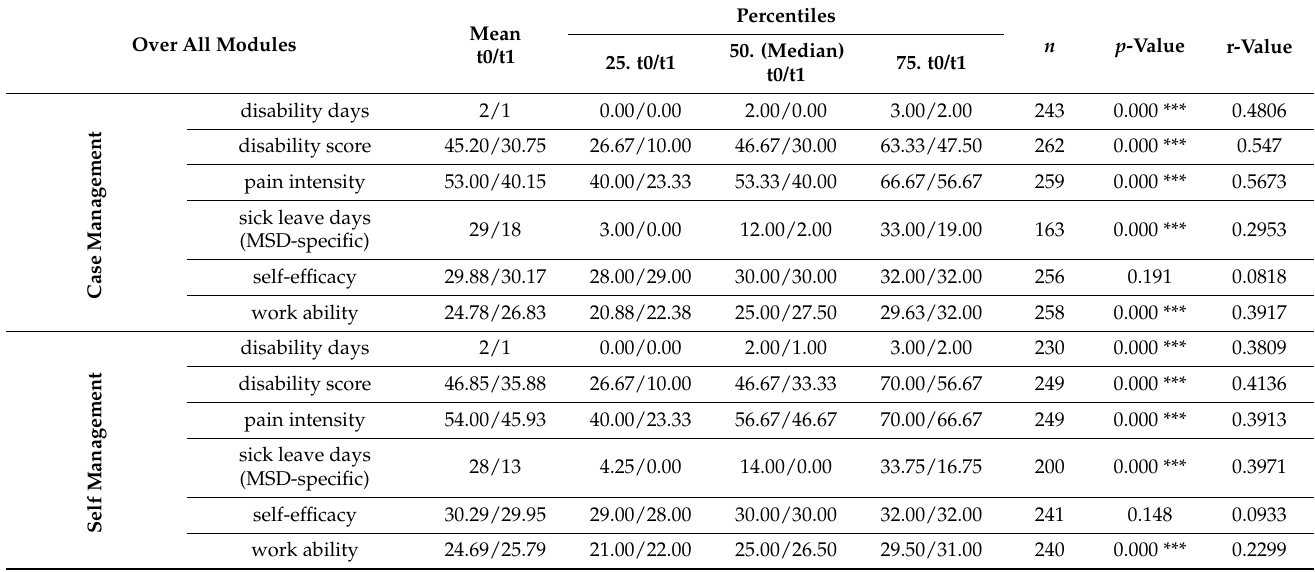
Table 2. Timepoint differences’ analyses: baseline (t0) vs. follow-up (t1), separately for coordinating case management (cCM) and supported self-management (sSM) (*** = p < 0.001).